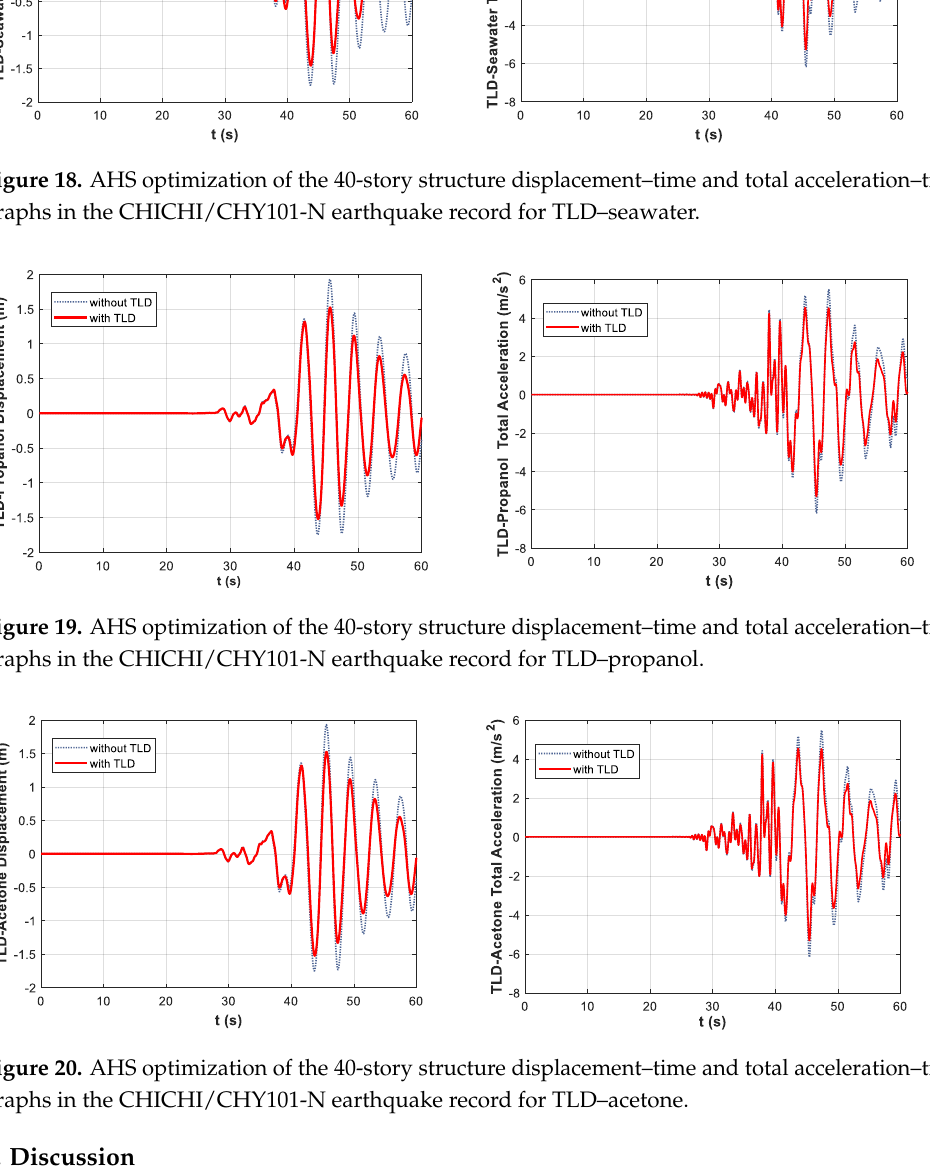
Figure 20. AHS optimization of the 40-story structure displacement – time and total acceleration – time graphs in the CHICHI/CHY101-N earthquake record for TLD – acetone.